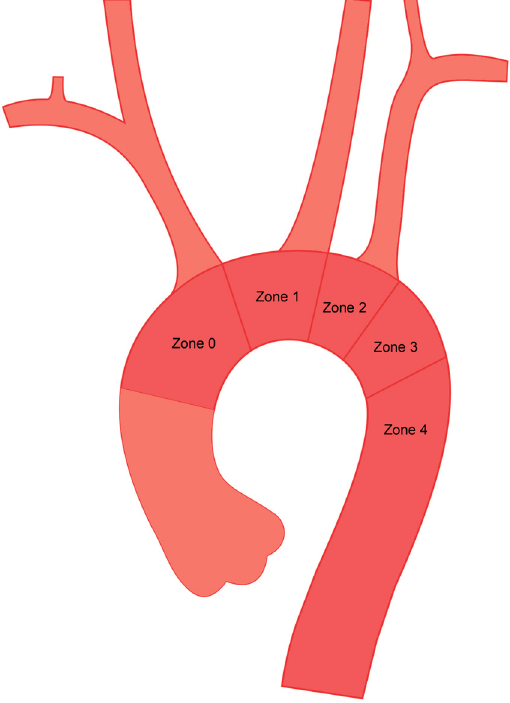
Fig. 2 - Anchoring zones of the thoracic aneurysm according to Ishimaru and Mitchell classification. In diseases that affect the Zones 0-2, revascularization procedures of the supra-aortic trunks are needed.